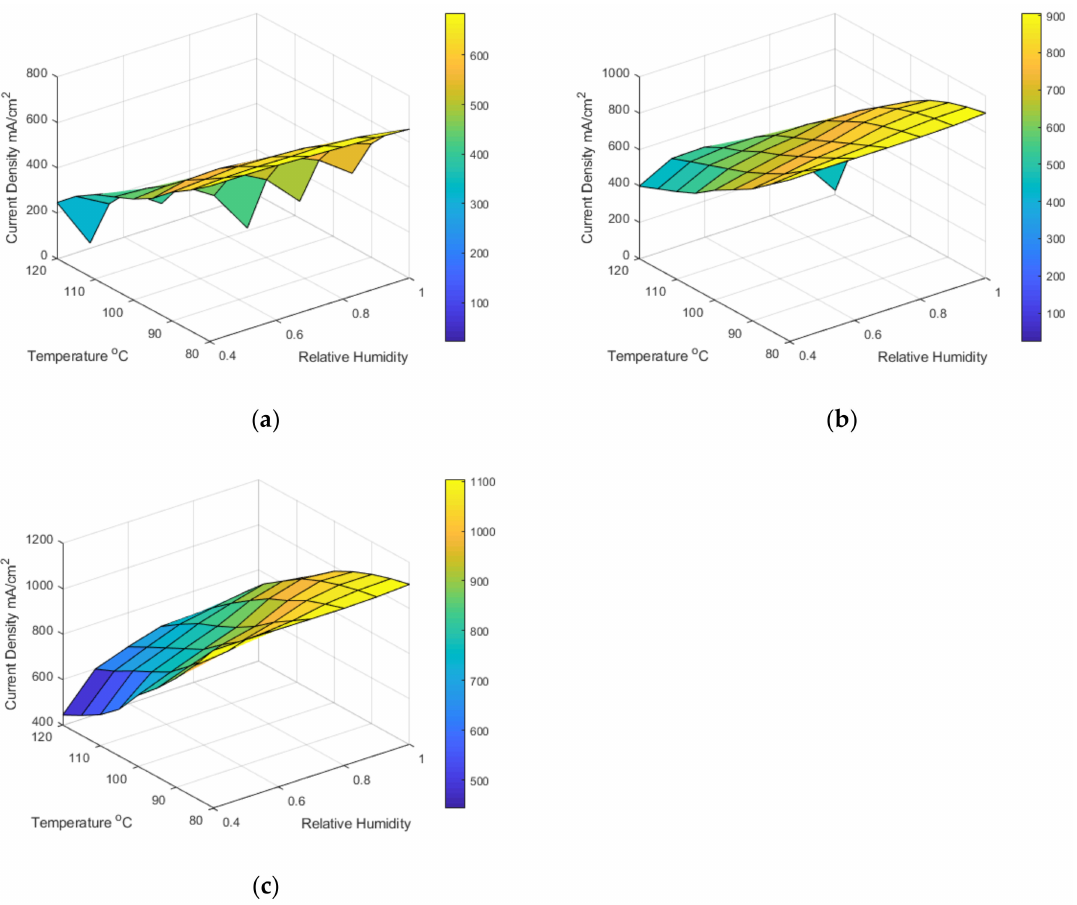
Figure 8. Surface plots of model current density prediction data at 0.6 V across 40–100% RH, 80–120 ◦ C, and ( a ) 1 bar, ( b ) 2 bar, and ( c ) 3